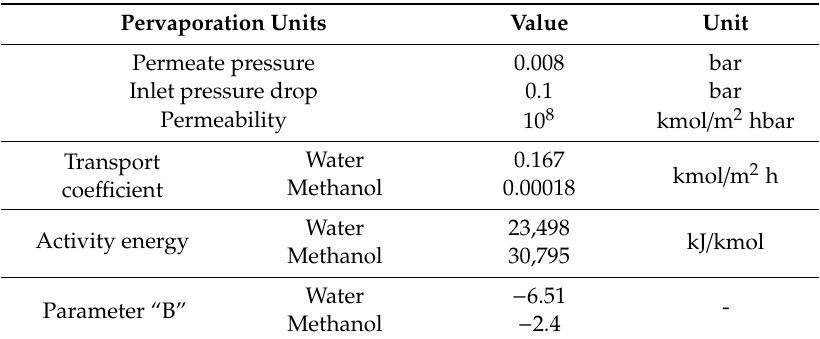
Table 4. Hydrophilic pervaporation membrane parameters for methanol-water mixture (PERVAP ™ 1510 type membrane) [70].